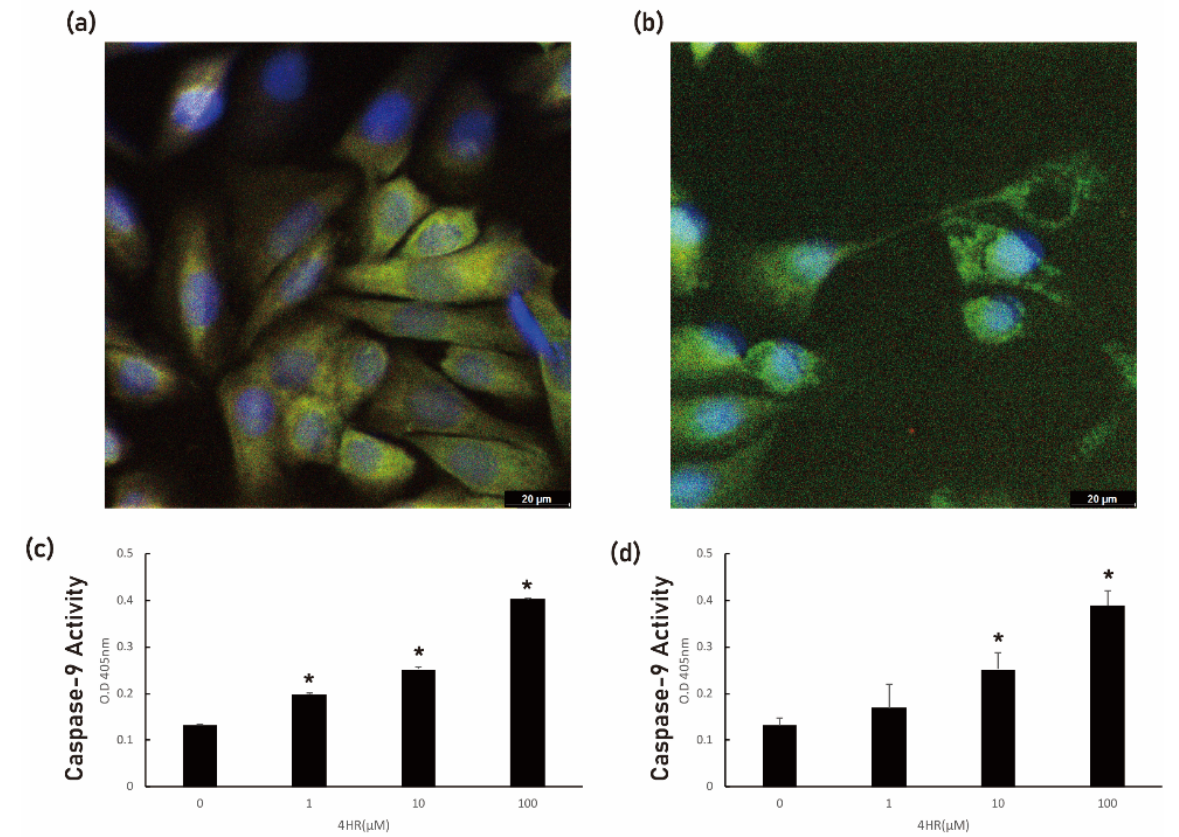
Figure 4. Treatment with 4HR increased apoptosis. The untreated control showed that cytochrome c (green) was co-localised with ATP synthase V (red). Accordingly, the cytoplasm appeared as a bright yellow colour ( a ). When YD-15 cells were treated with 100 µ M of 4HR, the cytoplasm appeared as a green colour due to cytochrome c release from the mitochondria ( b ). Caspase-9 activity was significantly increased upon 4HR treatment in both YD-15 ( c ) and YD-9 cells ( d ) (* p < 0.05).